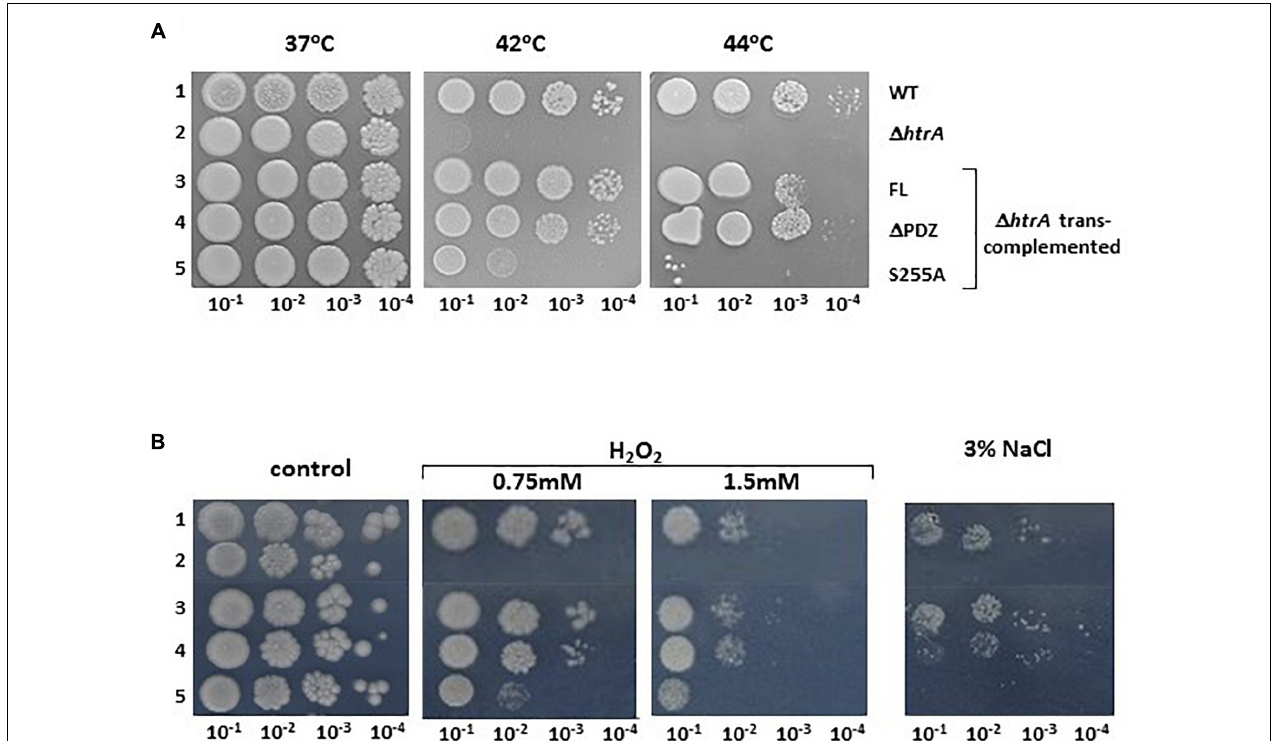
FIGURE 4 | Dilution drop agar-assay of the WT parental (cid:49) Vstrain (1), (cid:49) V (cid:49) htrA (2), and the trans -complemented strains (cid:49) V (cid:49) htrA/HtrA (3), (cid:49) V (cid:49) htrA/HtrA (cid:49) PDZ (4) and (cid:49) V (cid:49) htrA/HtrA S255A (5) under various stress conditions. (A) Alleviation of the heat sensitivity phenotype of the (cid:49) htrA strain by trans -complementation with the FL and (cid:49) PDZ forms of HtrA BA . Plates were incubated at the indicated temperatures. (B) Alleviation of the H 2 O 2 and NaCl sensitivity phenotype of the (cid:49) htrA strain by trans -complementation with the FL and (cid:49) PDZ forms of HtrA BA . Control LB-agar plates or LB plates containing the indicated concentrations of H 2 O 2 or NaCl were incubated at 37 ◦ C.